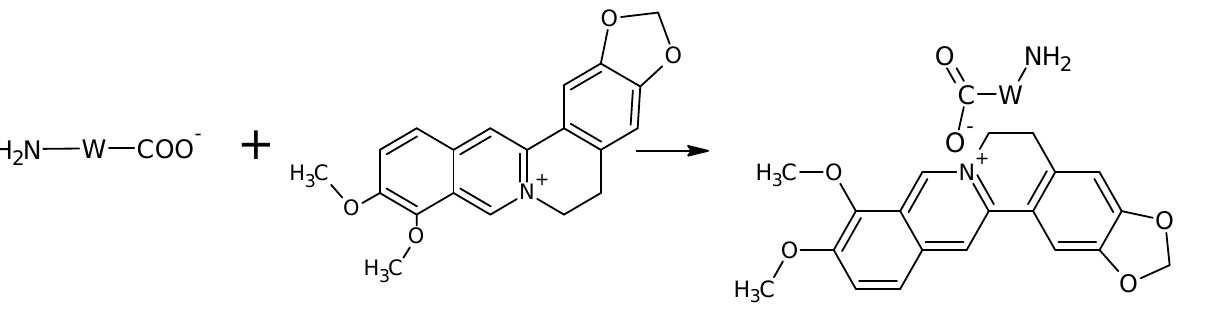
Figure 8. Proposed dyeing mechanism for untreated wool.